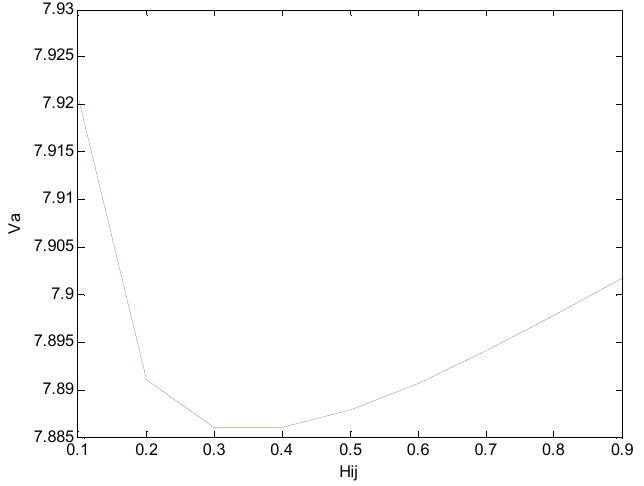
Figure A1. Relationship between h ij and Va .